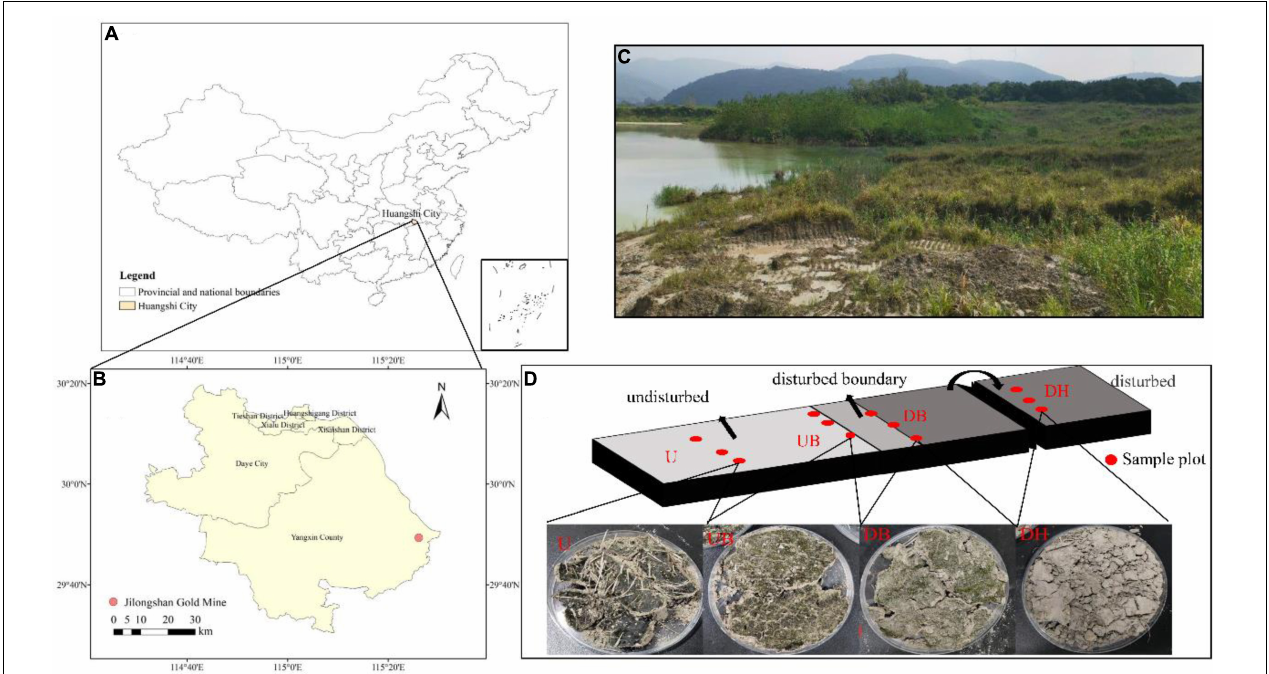
FIGURE 1 | Location of the gold tailings (A,B) , landscapes of the experimental area (C) , the diagram of the position where the samples were collected and a sample image of different disturbance areas (D) . DH- Heavily disturbed area; DB- disturbed boundary area; UB- Undisturbed boundary area approximately 1–1.5 m away from the disturbed boundary area; U-Undisturbed